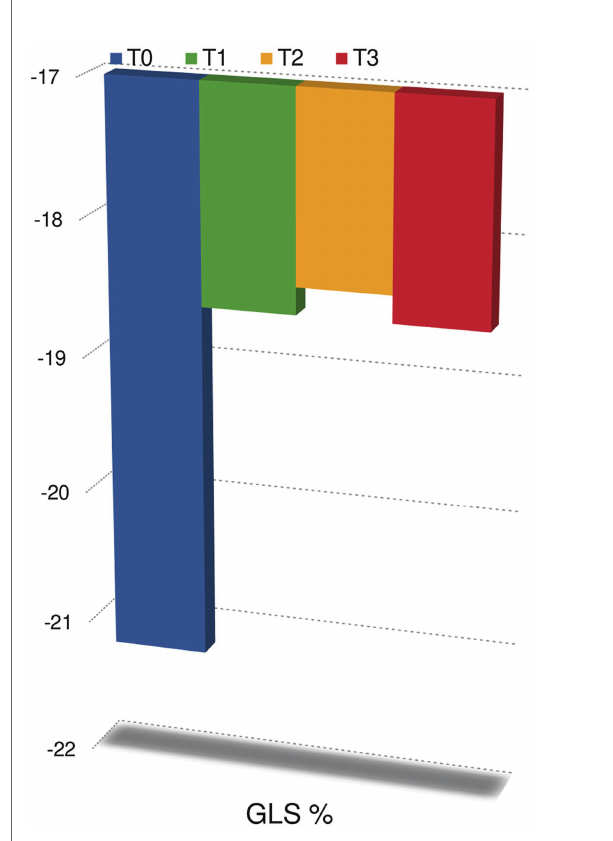
FIGURE 2 | Changes in global longitudinal strain during follow-up. p < 0.05 at anytime compared to T0.